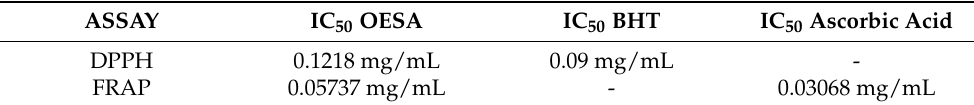
Figure 2. Ferric reducing antioxidant power (FRAP) assay of OESA. Various concentrations of OESA extracts (0 to 1 mg/mL) and acid ascorbic were mixed with FRAP reagents. The reduction of ferric ion (Fe 3+ ) to ferrous form (Fe 2+ ) by OESA produces an intense blue light revealed as a change in absorption at 700 nm. Results were expressed as mean inhibition percentage (%) ± standard devia- tions (n = 3). Ascorbic acid at various concentrations (0 to 1 mg/mL) was used as standard. Table 1. The IC 50 of OESA compared to the standard antioxidants, BHT, and ascorbic acid. ASSAY